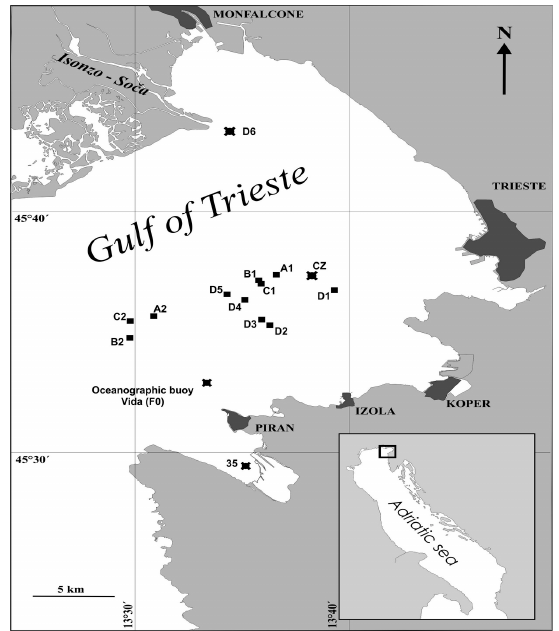
Figure 1. Map of the study area showing the sampling sites in the Gulf of Trieste (Northern Adriatic Sea), where ■ the four ray species and (sampling site F0) where the seawater and plankton samples were collected. Table 1. Biometric data of the four studied ray species [17].